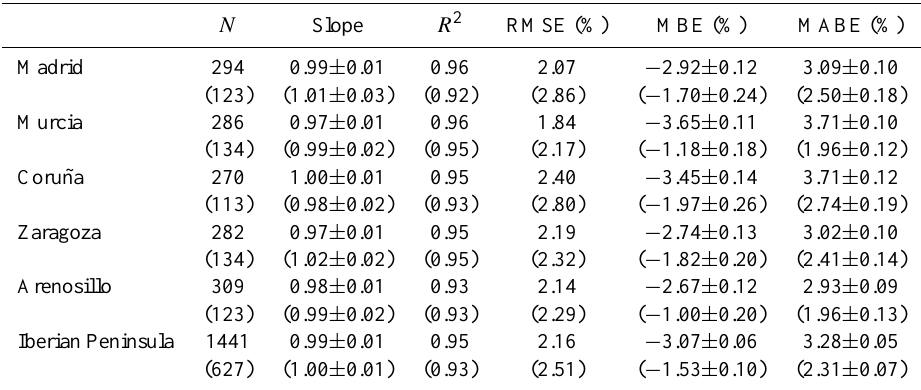
Table 1. Parameters obtained in the correlation analysis between GOME-2/MetOp ozone data and ground-based measurements. Results for the GOME/ERS-2 correlation are shown in